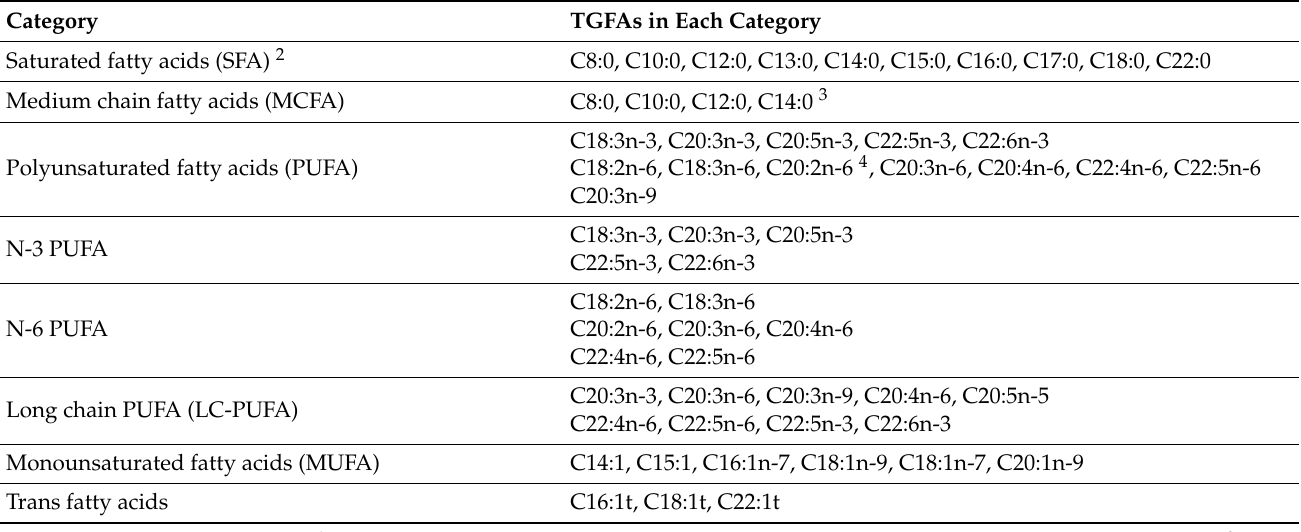
Table 1. TGFAs included in each fatty acid sub-category 1 . TGFAs in Each